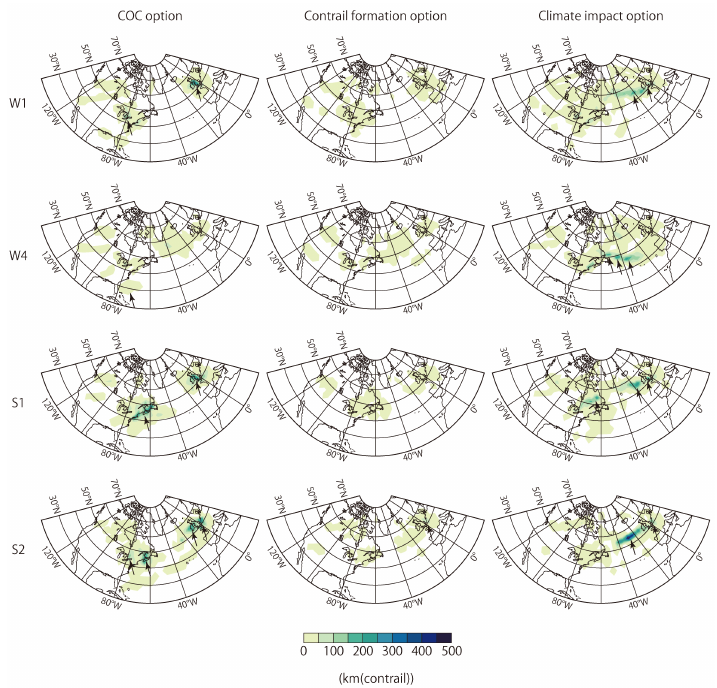
Figure 7. Vertically integrated distribution of contrail distance for types W1, W4, S1 and S2: ( left ) COC option; ( center ) contrail option; ( right ) climate option. The distributions represent the sum of 103 flights for 24 h of the respective days. The arrows indicate the region where the contrail formation changes